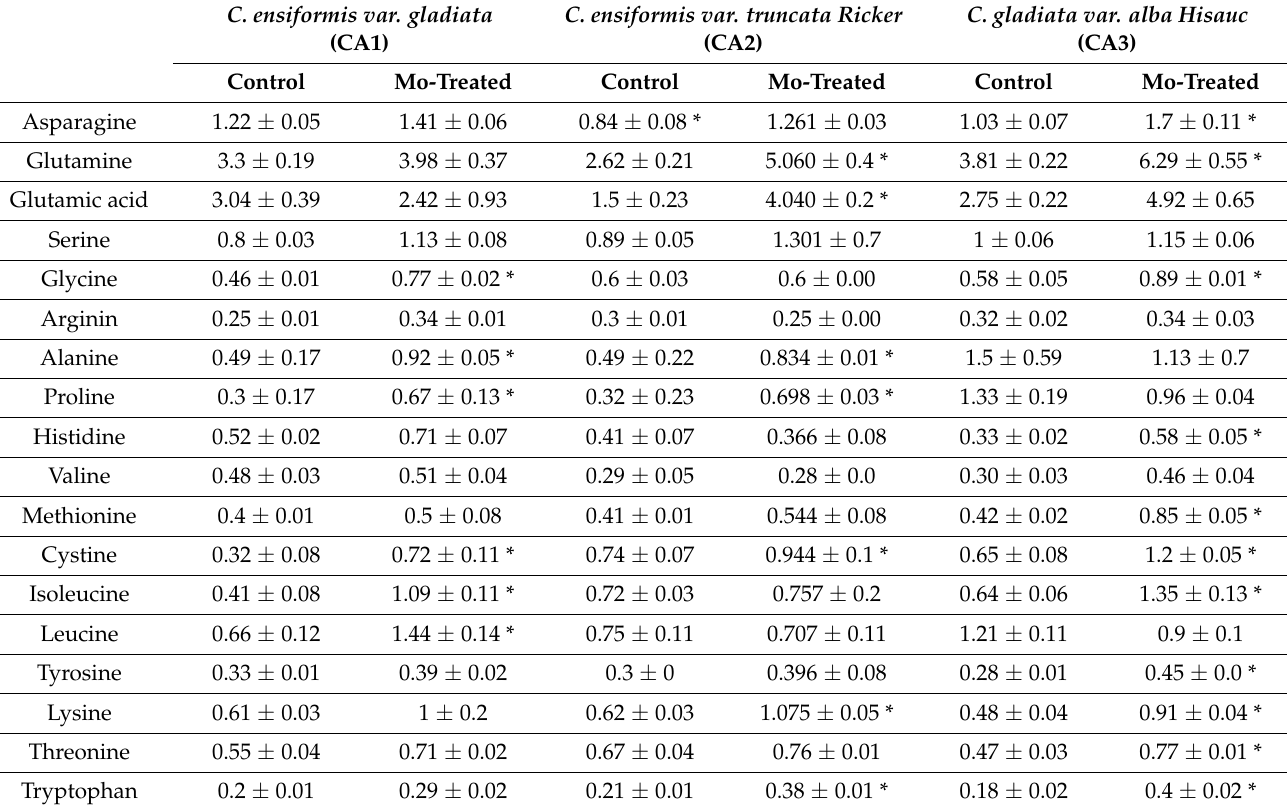
Table 2. Effect of molybdenum treatment on amino acid content ( µ mol/ gFW) of Canavalia species/cultivar sprouts. Experiments were carried out in triplicate and the data are expressed as mean ± standard deviation (S.D); Level of significance, * p < 0.05; Mo,